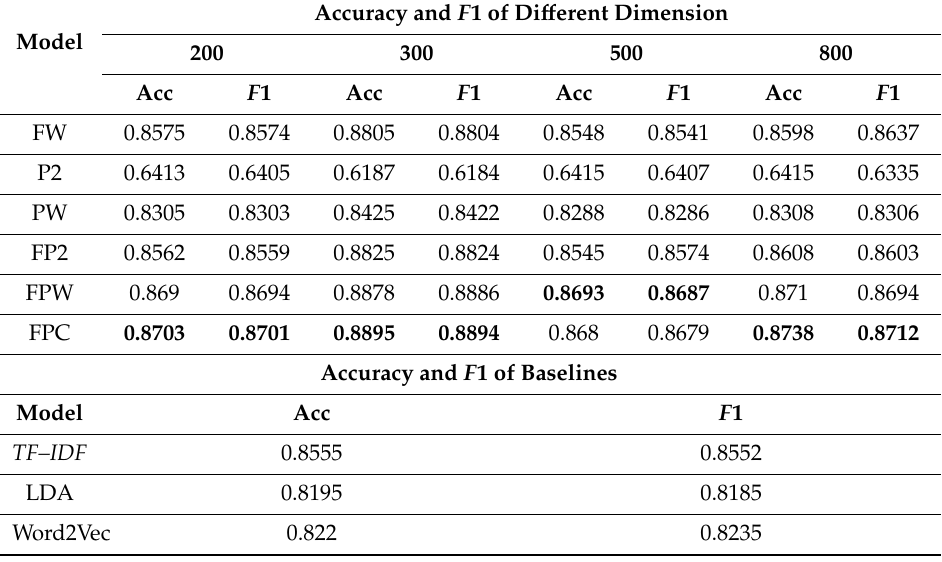
Table 10. Results of laptops in ChnSentiCorp by